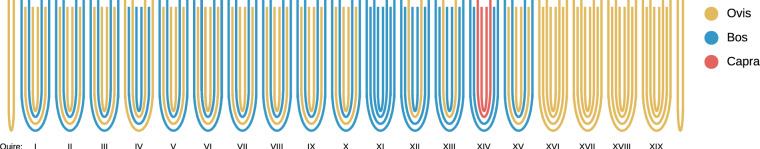
Manual classification of the Glossed Luke Manuscript arranged by quire. Illustration based on the figure in Gibbons (2017, p. 349)